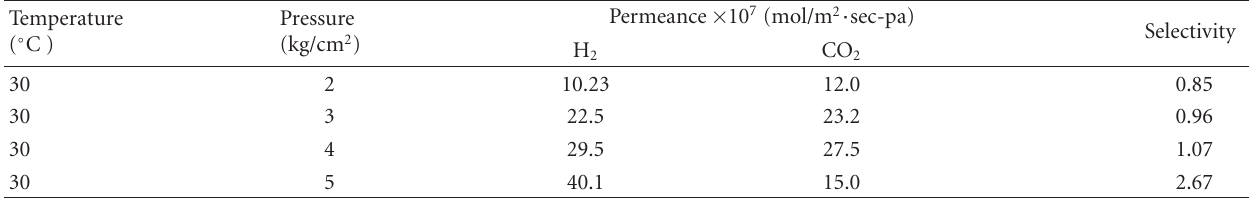
Table 1: Room temperature single gas permeation for H 2 and CO 2 through SAPO 34 membrane on untreated support at 30 ◦ C. Temperature